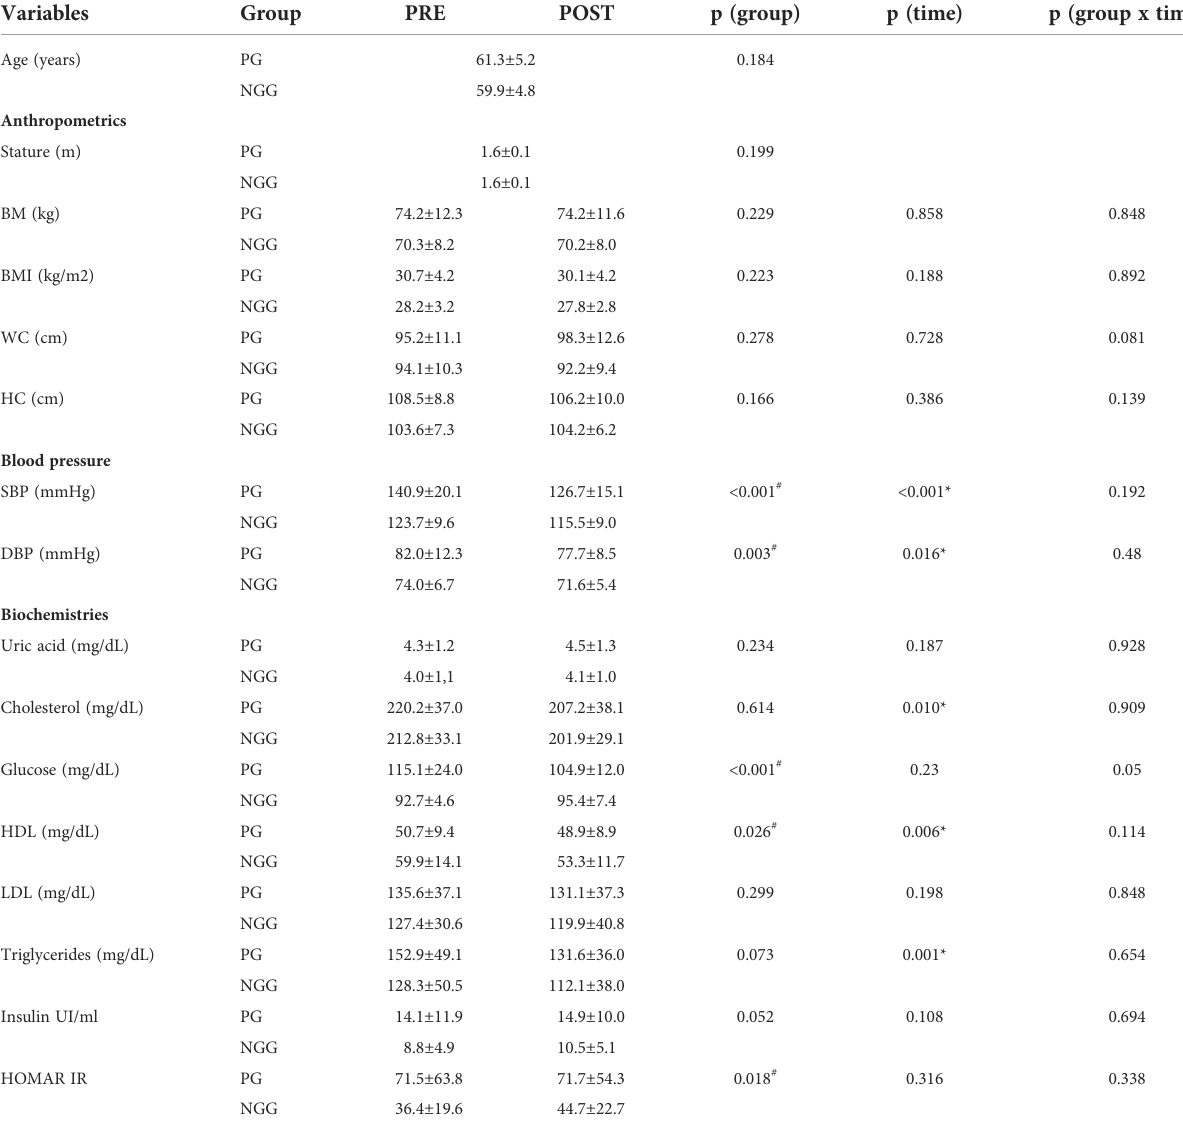
TABLE 1 Mean ± standard deviation of anthropometric, blood pressure, and biochemical variables pre and post-14 weeks of combined training (PG: n = 24; NGG: n = 24). Variables